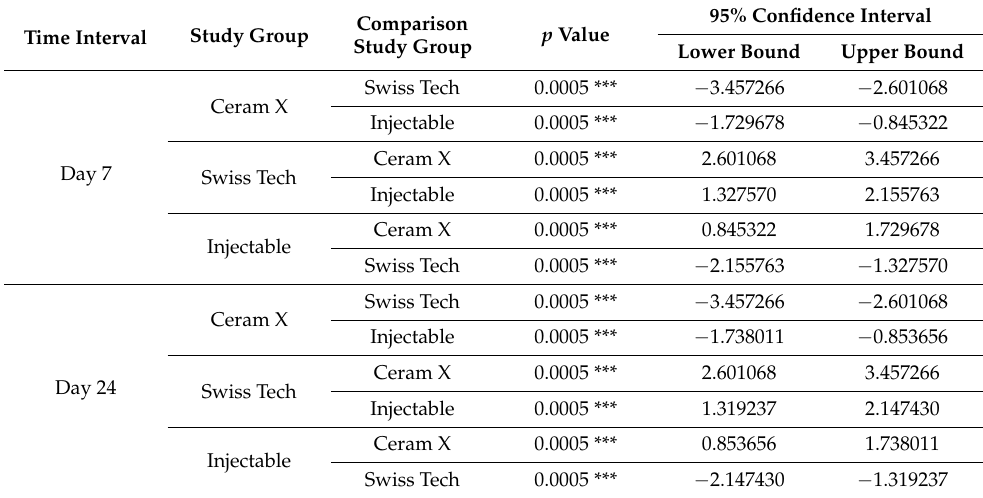
Table 5. Post-Hoc Intergroup comparative evaluation of the monomer elution from three resincom- posite at different time interval. Time Interval Study